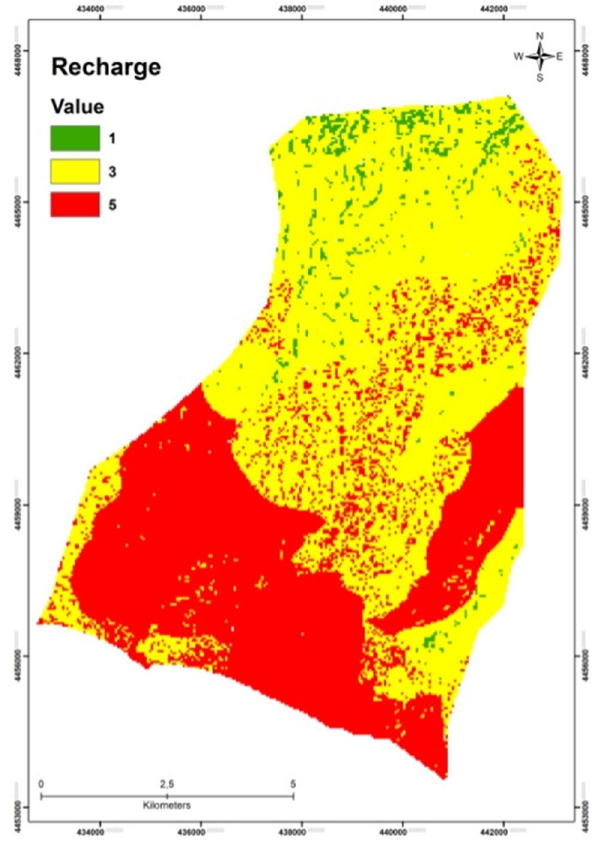
Fig. 2 Recharge of the study